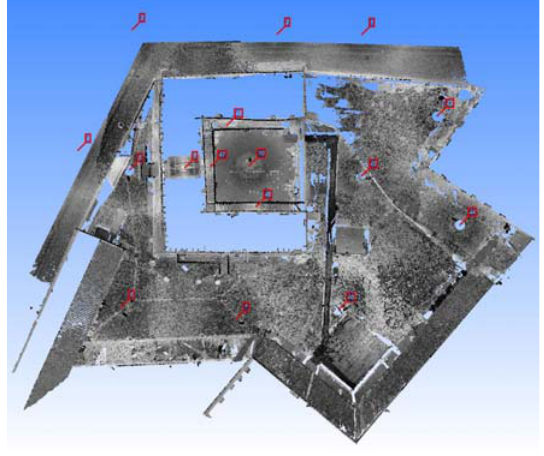
Fig. 7: Point of scans